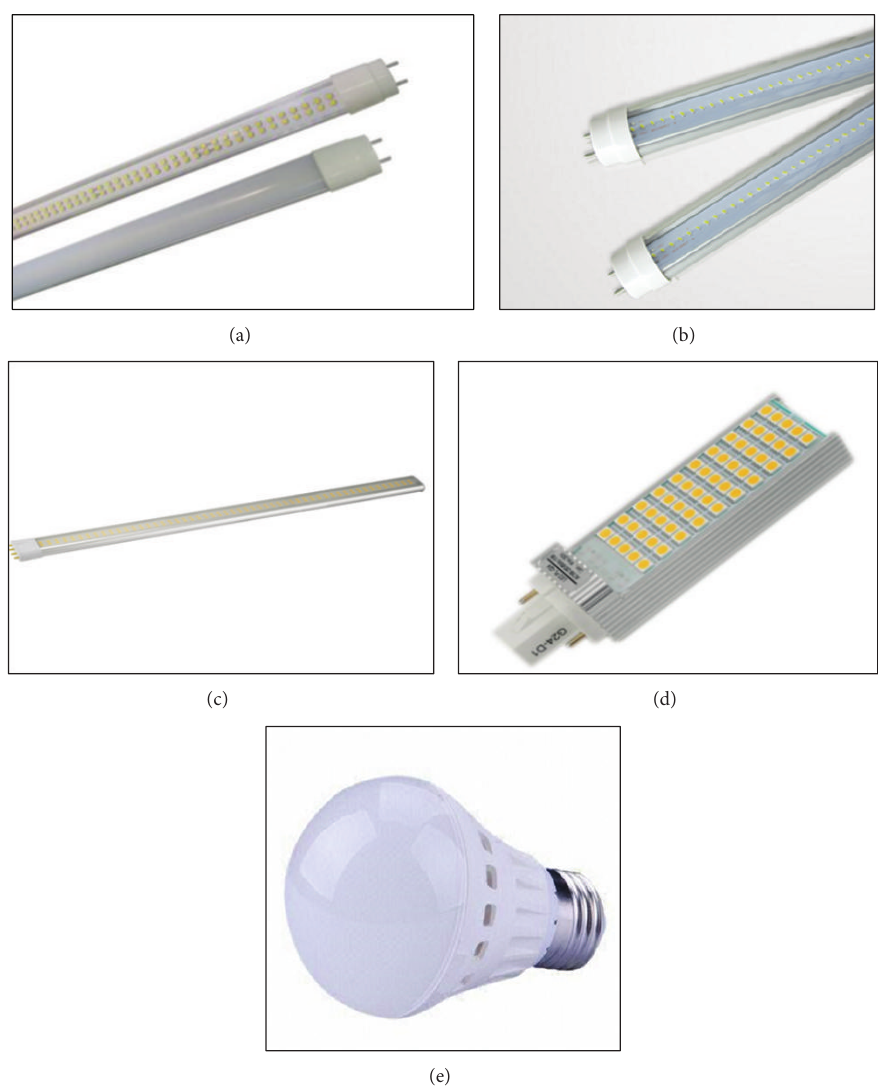
Figure 4: (a) 20W 4 feet LED tube replacing 36 W fluorescent tube, (b) 10 W 2 feet LED tube replacing 18W fluorescent tube, (c) 22 W/4 pin LED tube replacing Philips 36 W/4 Pin, (d) 8 W/2pin LED replacing Philips PL-C 13W/2 pin, and (e) 9 W LED bulb light replacing Philips 14W (CFL)